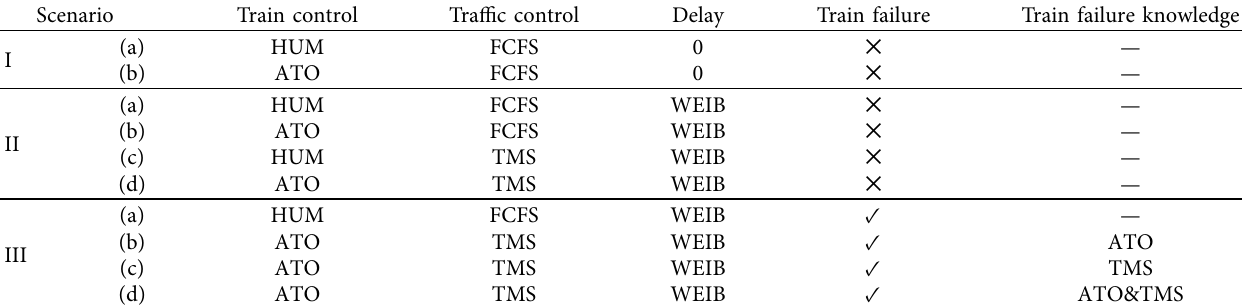
Table 3: Scenarios (HUM: simulated human driver; FCFS: first come first serve; WEIB: Weibull distribution).